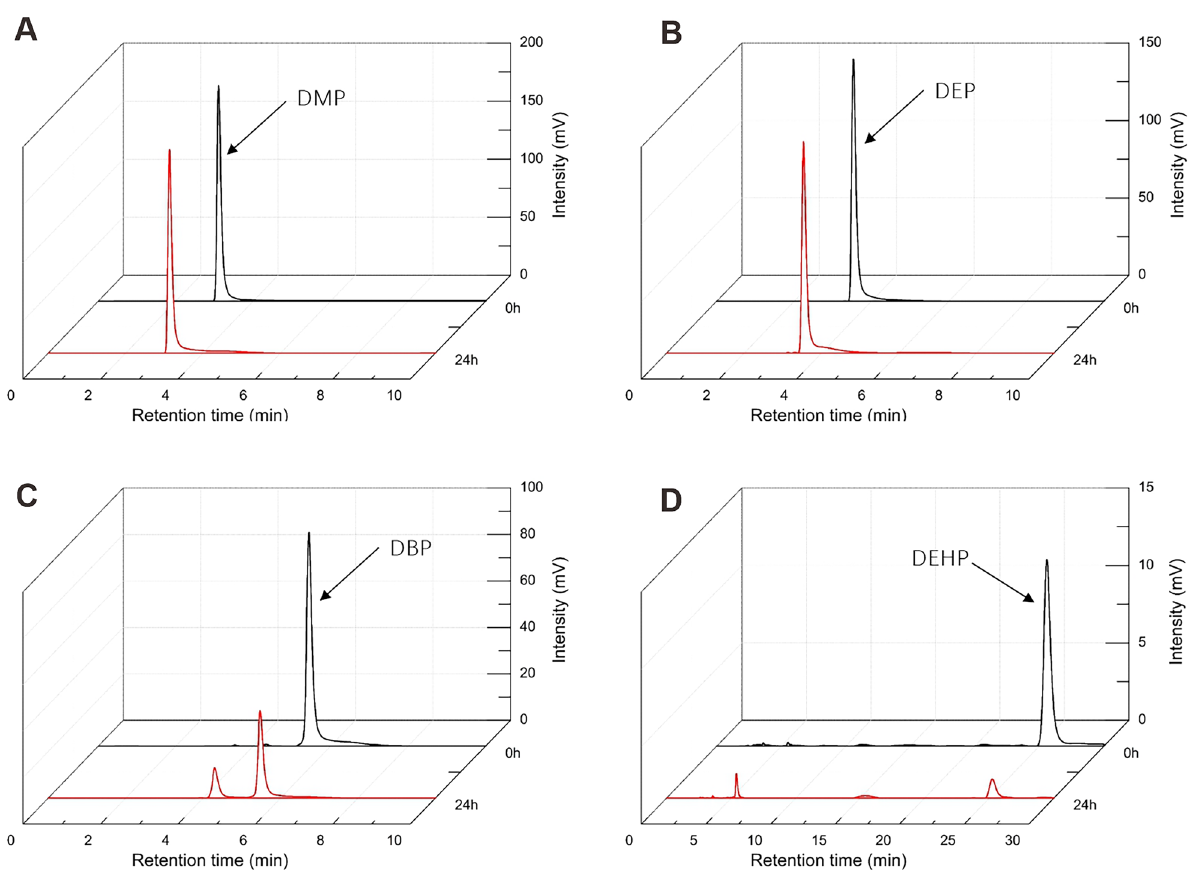
Figure 1. HPLC elution profiles (red lines) of substrate and metabolites during growth of strain LMB-7, using ( A ) DMP, ( B ) DEP, ( C ) DBP and ( D ) DEHP as the sole carbon source, respectively, after 24 h of incubation. Black lines are from reference standards of single